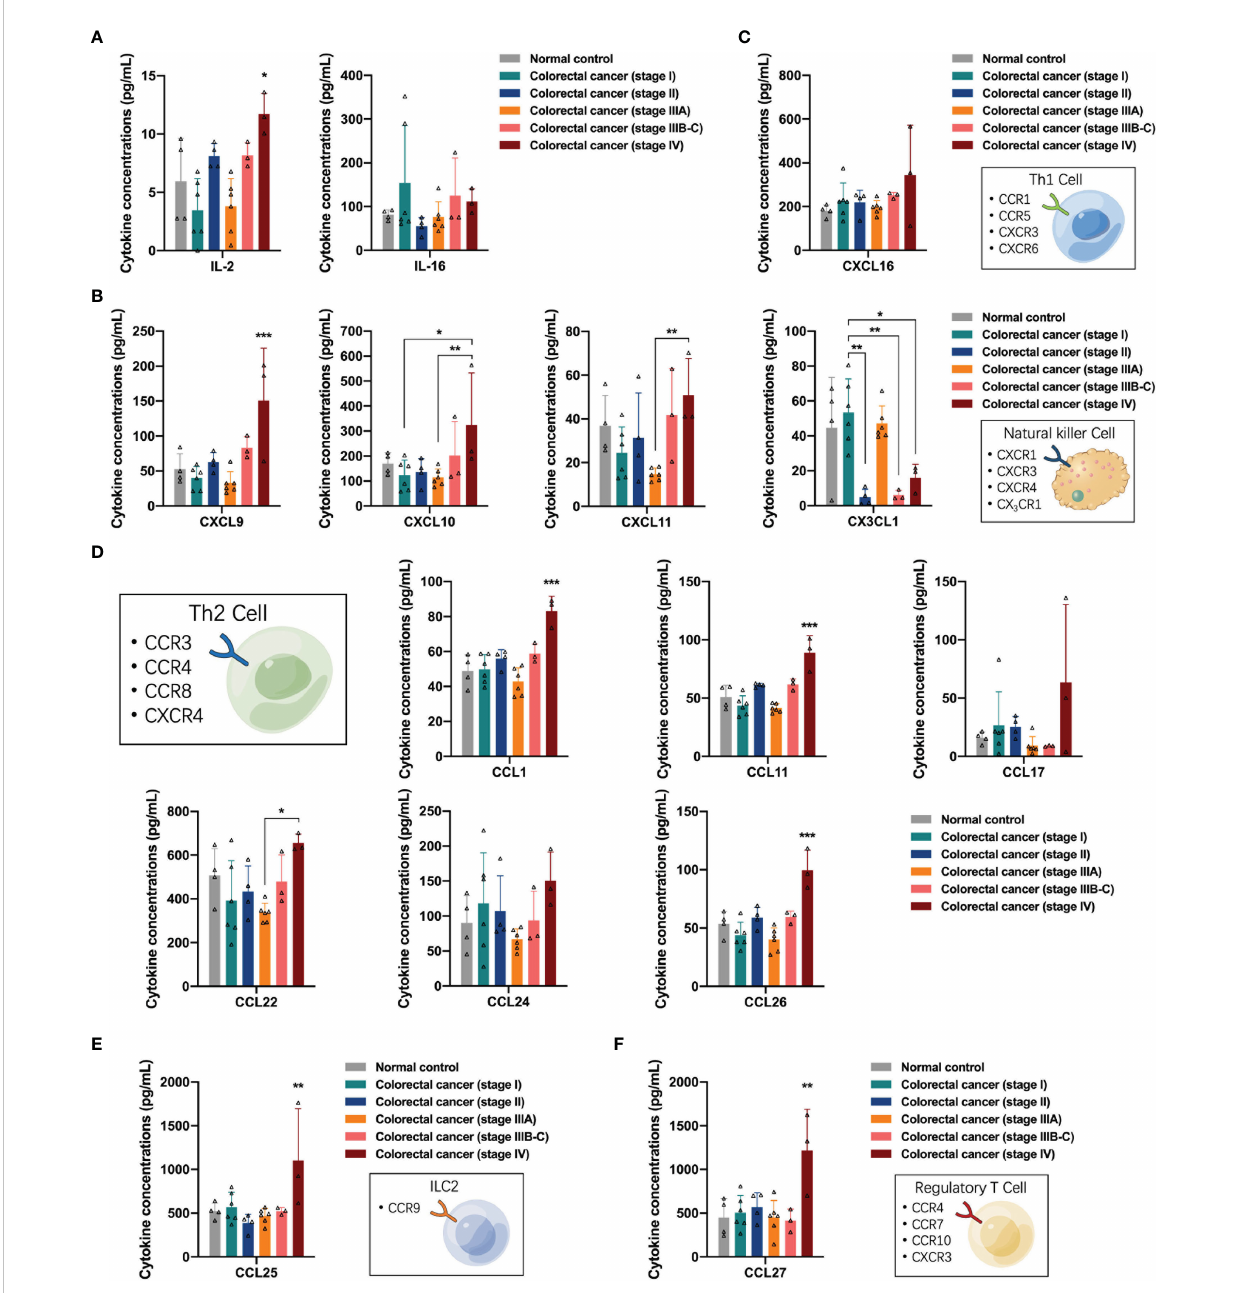
FIGURE 5 Distribution of lymphocytes-associated cytokines in the peripheral blood of the participants. (A) The concentrations of T-cell growth factor IL-2 were signi fi cantly increased in peripheral blood of patients with stage IV colorectal cancer. (B) The concentrations of CXCL9, CXCL10, and CXCL11 in the peripheral blood of patients with stage IV colorectal cancer were increased, and the concentrations of CX3CL1 in the peripheral blood of patients with stage II, IIIB-C and IV colorectal cancer were decreased. (C) Distribution of Th1 cell-related cytokines in the peripheral blood of participants. (D) The concentrations of CCL1, CCL11, CCL17, CCL22, and CCL26 were differentially elevated in the peripheral blood of patients with stage IV colorectal cancer. (E) Distribution of CCL25 in the peripheral blood of the participants. (F) Distribution of CCL27 in the peripheral blood of the participants. Data are presented as mean±SD, one-way ANOVA, *p<0.05, **p<0.01,